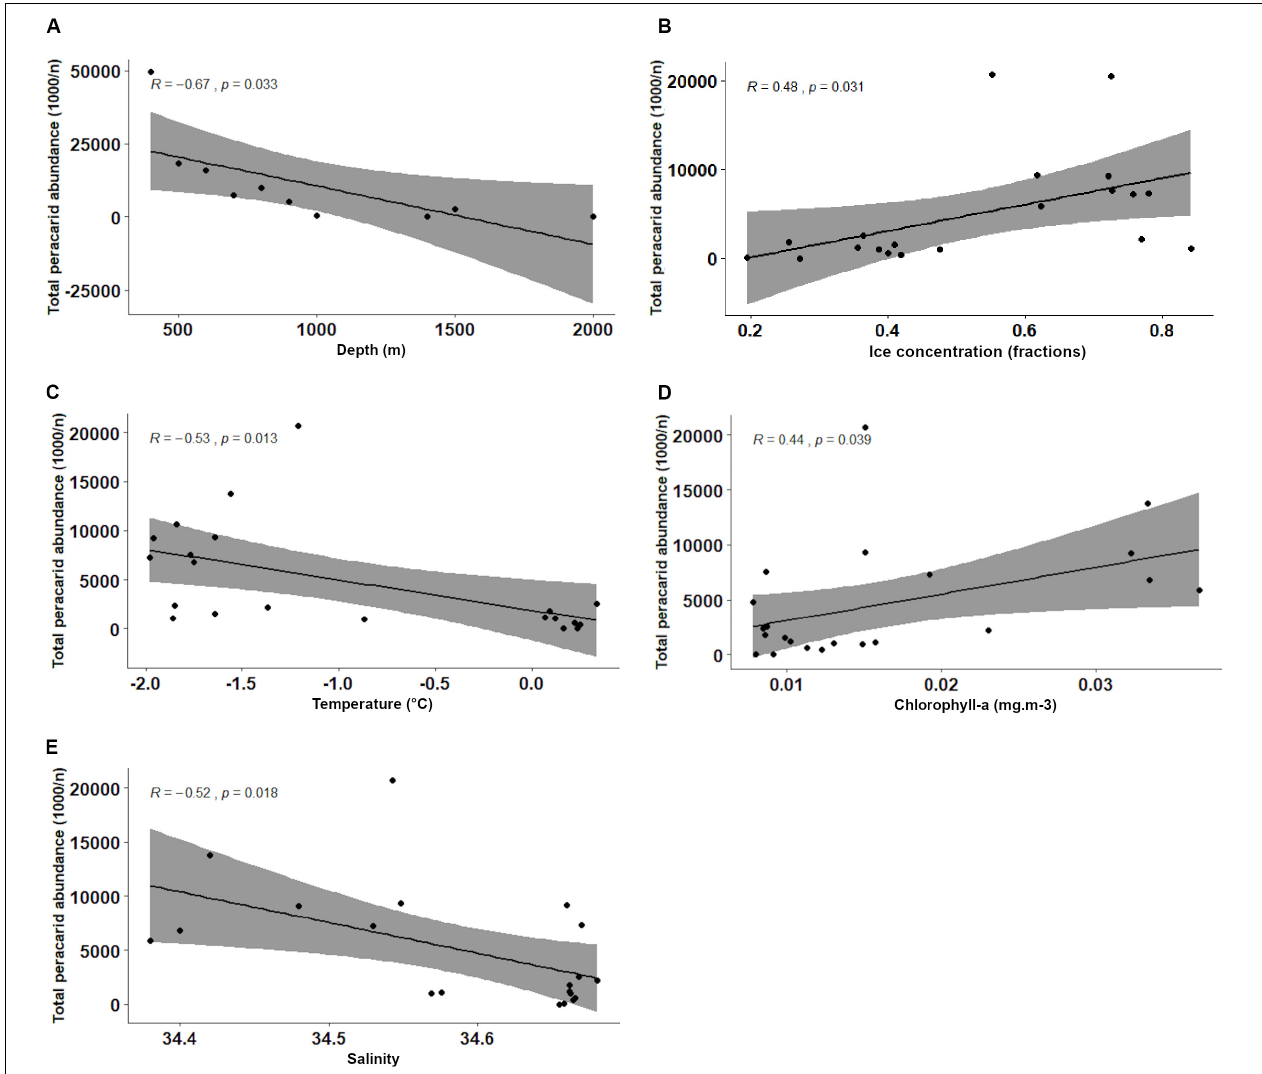
FIGURE 6 | Pearson’s correlation analyses of peracarid abundances and environmental variables: depth (A) , ice concentration (B) , temperature (C) , chlorophyll-a (D) , salinity (E)